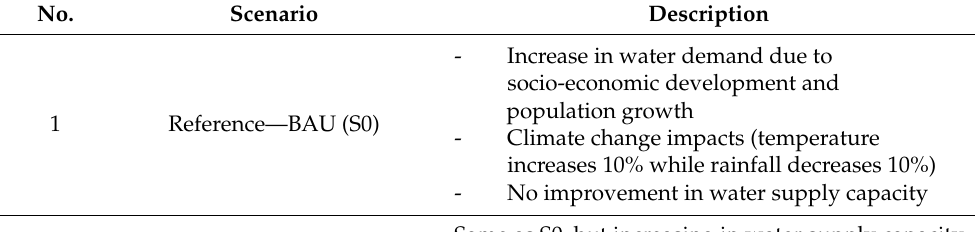
Table 2. Summary of water resources management scenarios for Con Dao